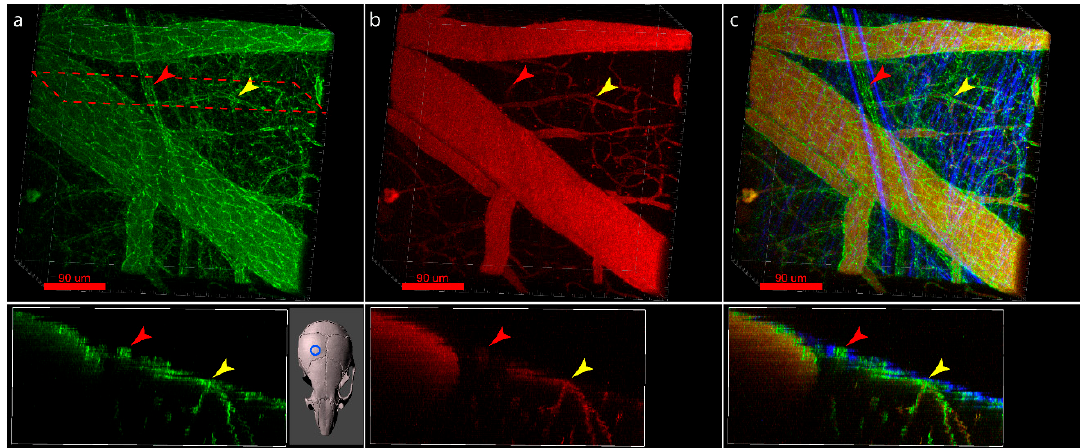
Figure 6. Visualization of CNS and meningeal endothelial AJs using the VE-Cadherin-GFP reporter mouse. ( a ) Cranial window allowing to visualize meningeal, subarachnoid, subpial and cortical vascular VE-cadherin-GFP + AJs. ( b ) Cranial window preparation from (a) highlighting blood vessels after i.v. injection of TRITC Dextran. ( c ) Overlay of a and b and the second harmonic generation of the collagen fibers in the dura allow to distinguish VE-cadherin-GFP + TRITC + blood vessels and VE-cadherin-GFP + TRITC neg lymphatic vessels in the dura mater. Examples of blood and lymphatic vessels of similar caliber size are highlighted with a yellow and red arrowhead, respectively. The cranial window was placed over the right hemisphere of the mouse brain as depicted in the insert below (a). Top row—3D stack, bottom—XZ maximum intensity projection of 20 µ m along Y at the cross section highlighted at the top. Scale bars = 90µm.